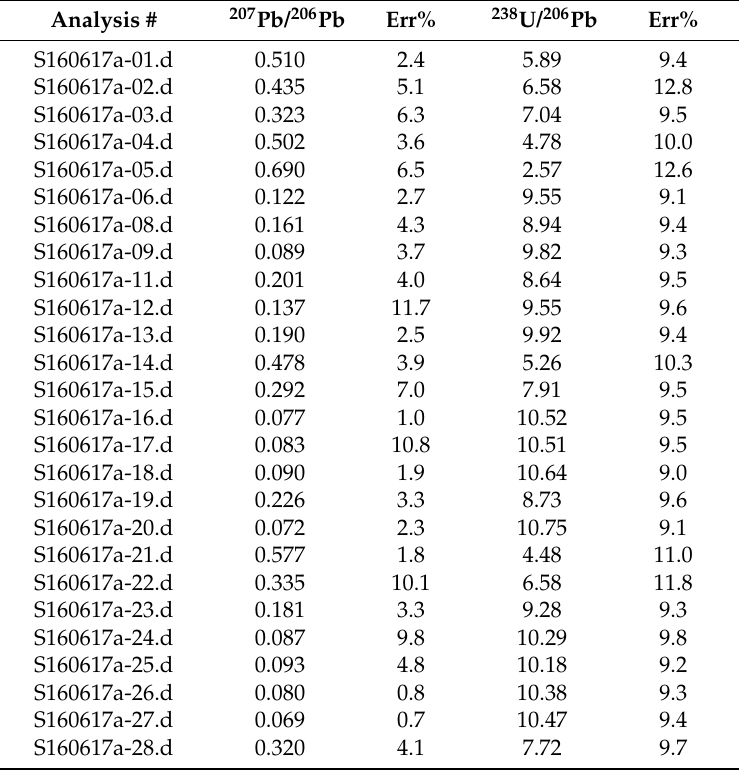
Table 3. LA-ICP-MS U-Th-Pb data on bastnaesite standardized with Calcite Standard